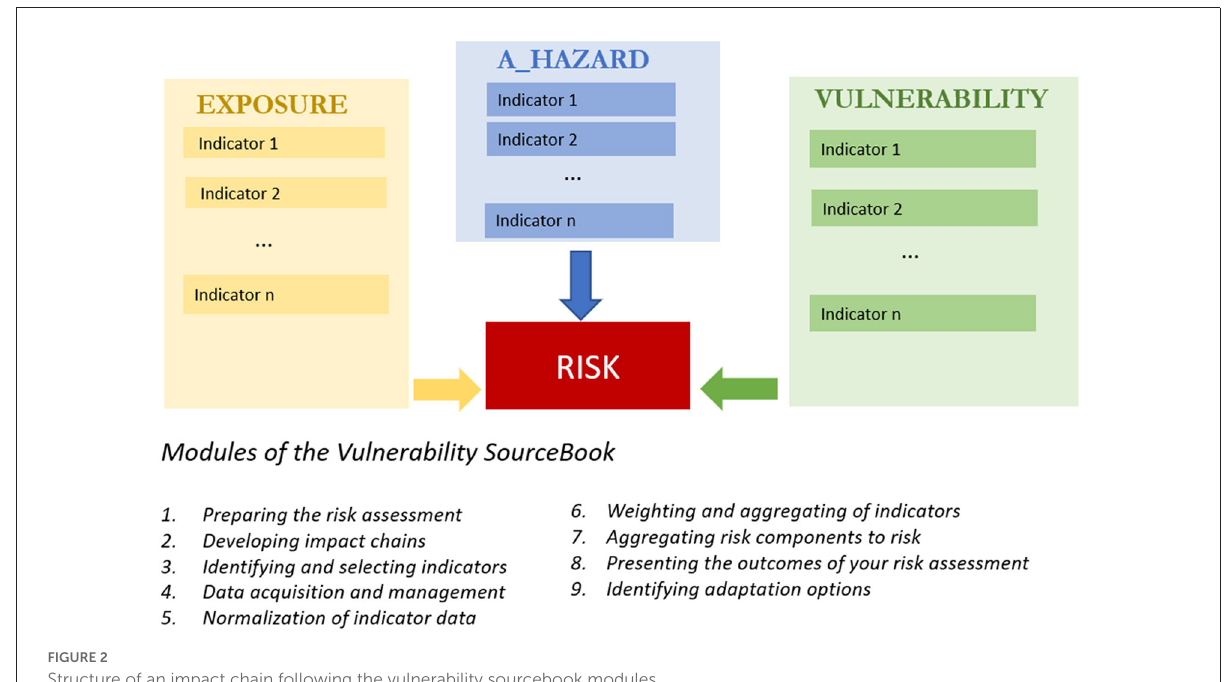
FIGURE2 Structure of an impact chain following the vulnerability sourcebook